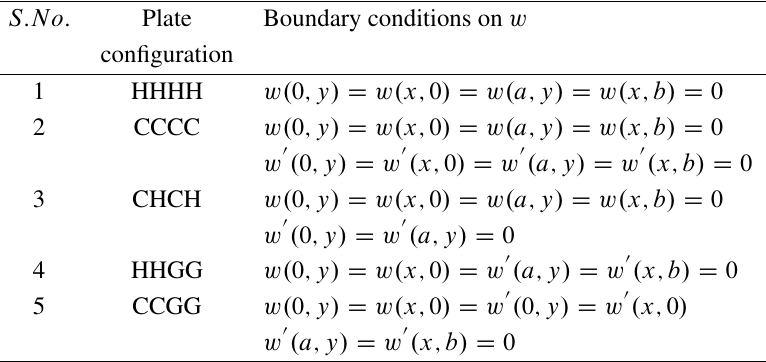
Table 2. Essential edge boundary conditions considered for the various rectangular plate configurations with the addi- tional in-plane displacement constraints ( u.0; y/ = u.a; y/ = v.x; 0/ = v.x; b/ =0). S:No: Plate Boundary conditions on w